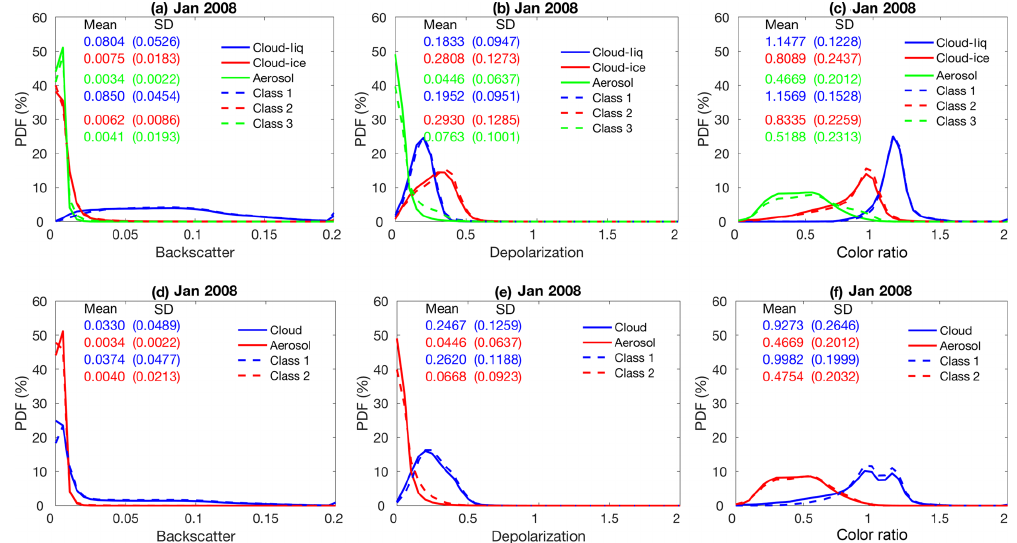
Figure 6. PDFs derived from all data from January 2008. The top row compares V4 operational CAD PDFs to the PDFs derived from CAD FKM three-class results. V4 CAD PDFs for liquid water clouds, ice clouds, and aerosols are plotted in, respectively, solid blue, red, and green lines. Similarly, CAD FKM three-class PDFs for classes 1, 2, and 3 are plotted in, respectively, dashed blue, red, and green lines. The bottom row compares V4 operational CAD PDFs to the PDFs derived from CAD FKM two-class results, where once again the V4 CAD PDFs are shown in solid lines and the CAD FKM two-class PDFs are shown in dashed lines. PDFs of (cid:104) β (cid:48) PDFs in the center column (b, e) , and χ (cid:48) PDFs in the right column (c, f) .